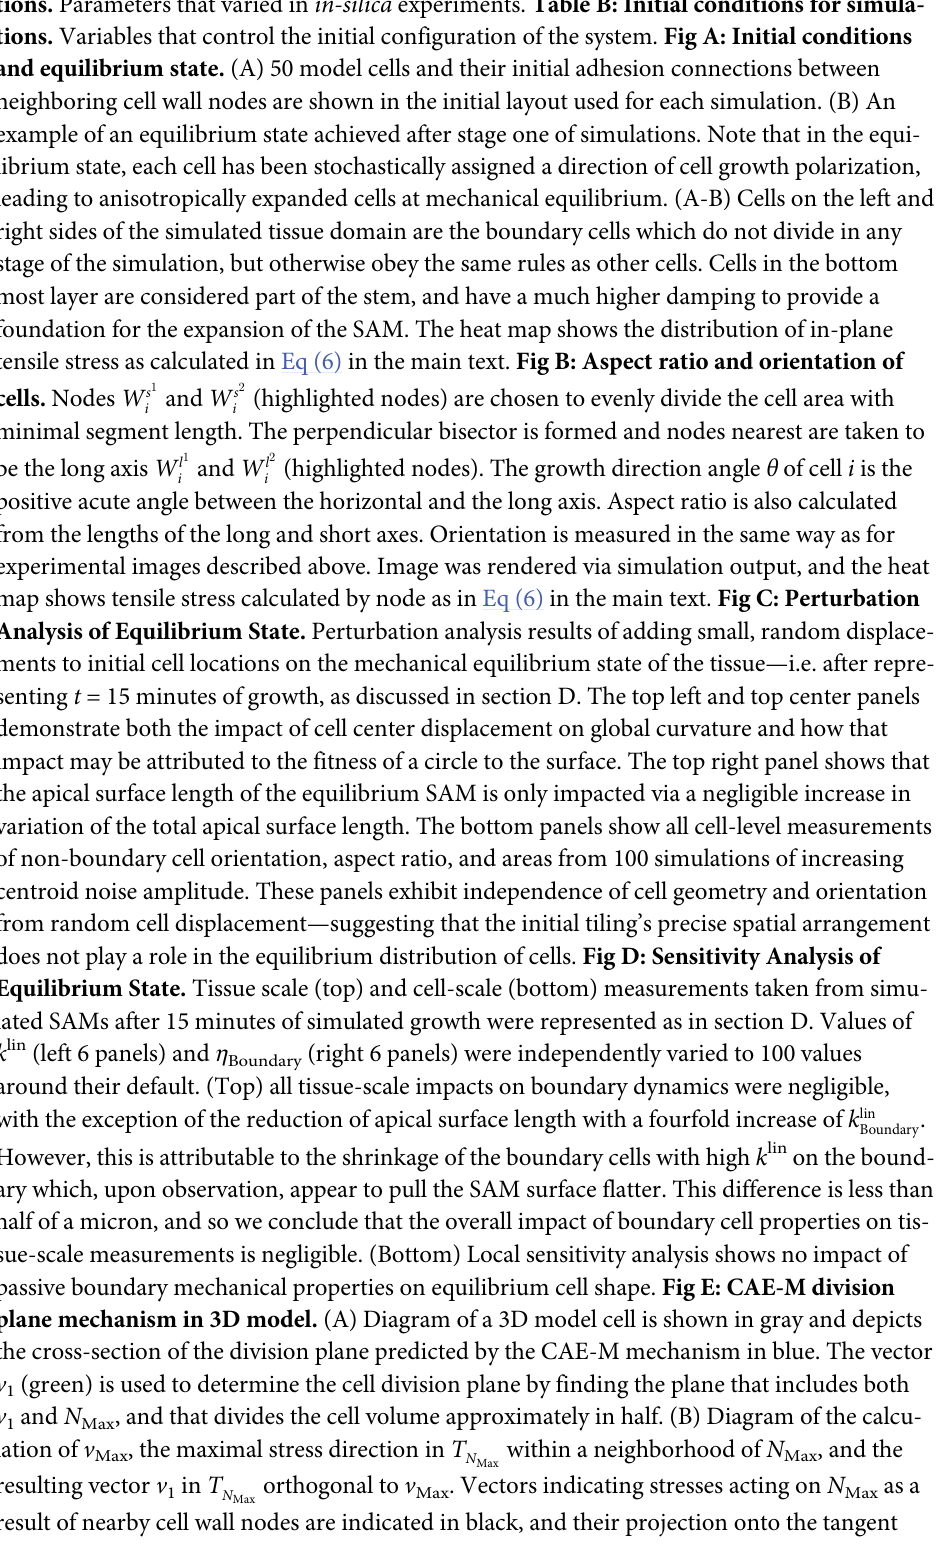
S3 Appendix. Extended model description. Table A: Main parameter values for